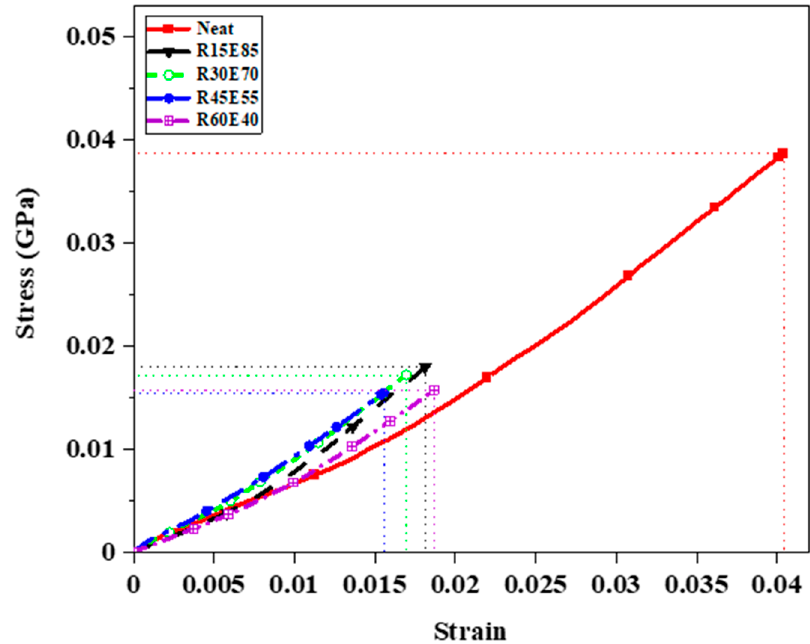
Figure 9. Stress–strain plot of test samples under a tensile load.